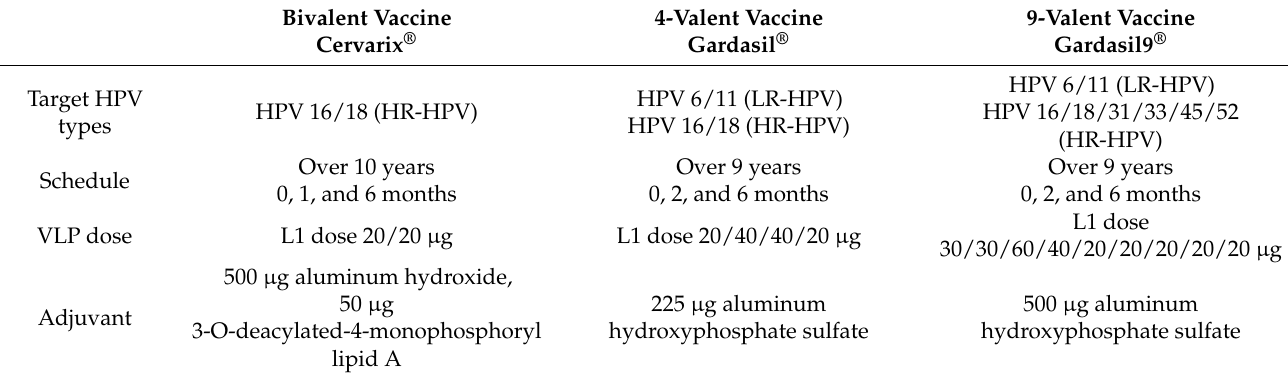
Table 1. Information of available HPV